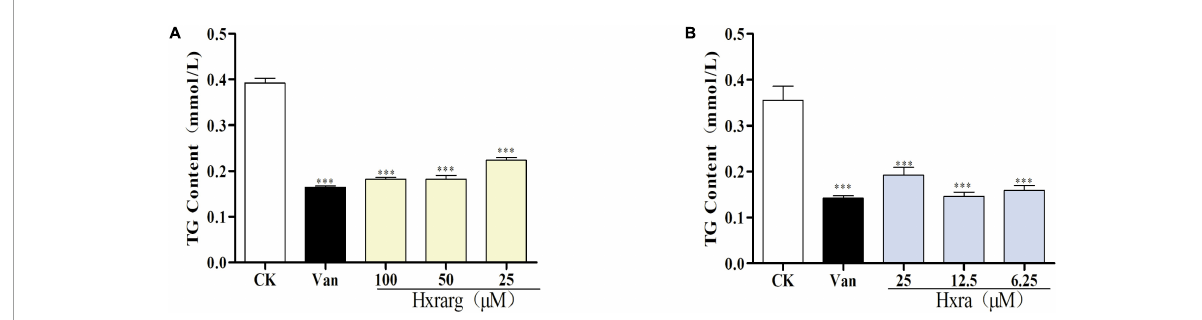
FIGURE5 Effects of Hxrarg (A) and Hxra (B) on TG contents in 3T3-L1 cells differentiation. Compared with control group, ∗∗∗ P < 0.001.